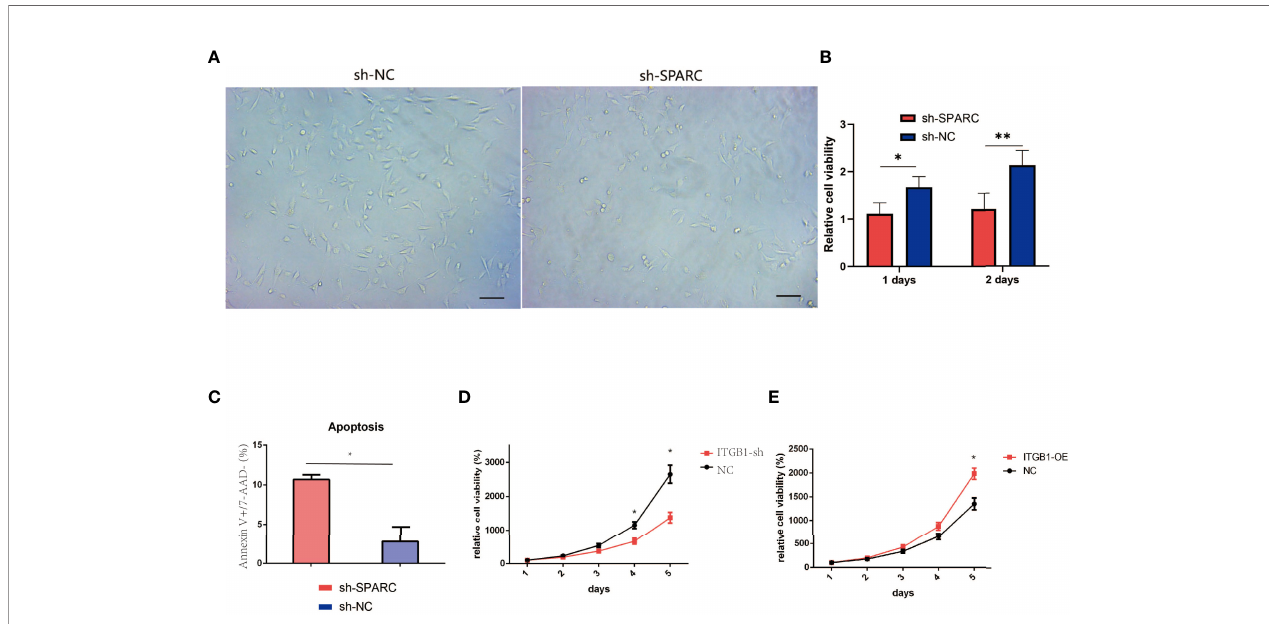
FIGURE 8 | Cell viability experiments test by CCK-8 analysis. (A) Representative fi gure of cell viability experiment. (B) The cell viability experiments in ablation of SPARC in 1 and 2 days. (C) Apoptosis of Annexin V+/7-AAD − experiment. (D , E) The cell viability experiments in 1, 2, 3, 4, 5 days with overexpression and ablation of ITGB1. *: p < 0.05, **: p < 0.01.